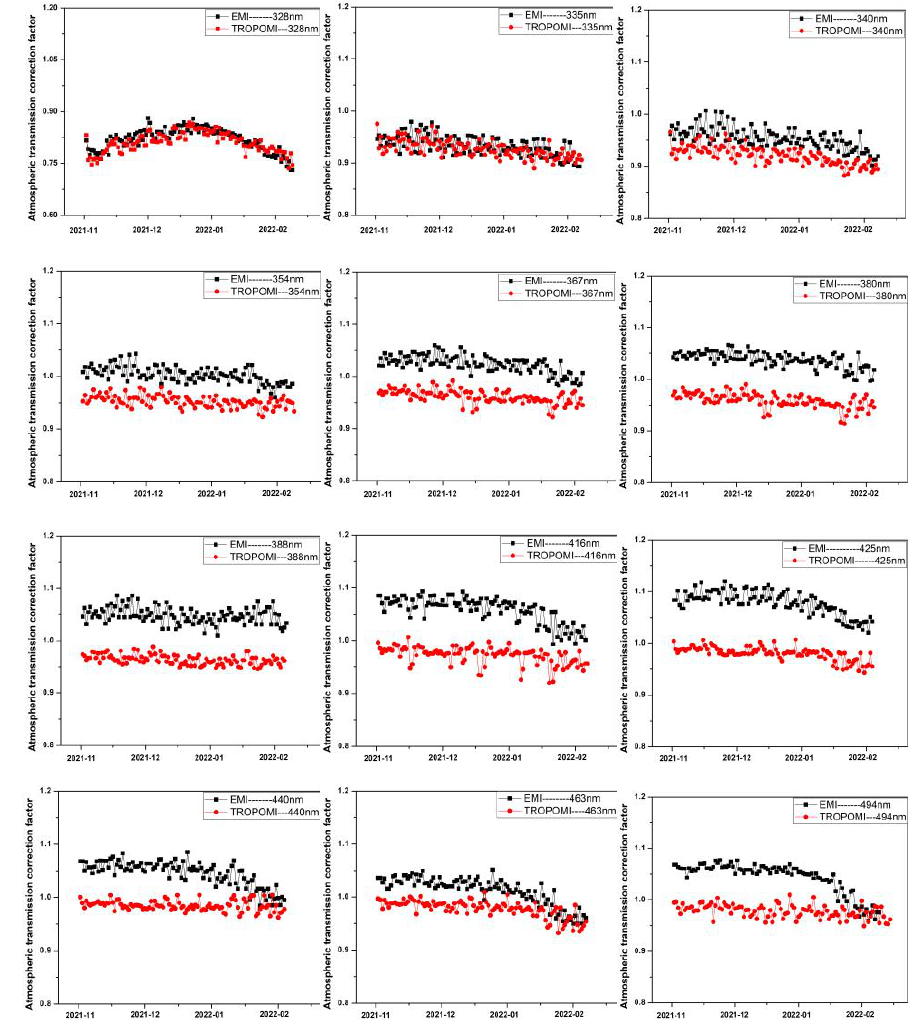
Figure 9. Time series of atmospheric transmission correction factor between EMI-2 and TROPOMI for twelve bands.